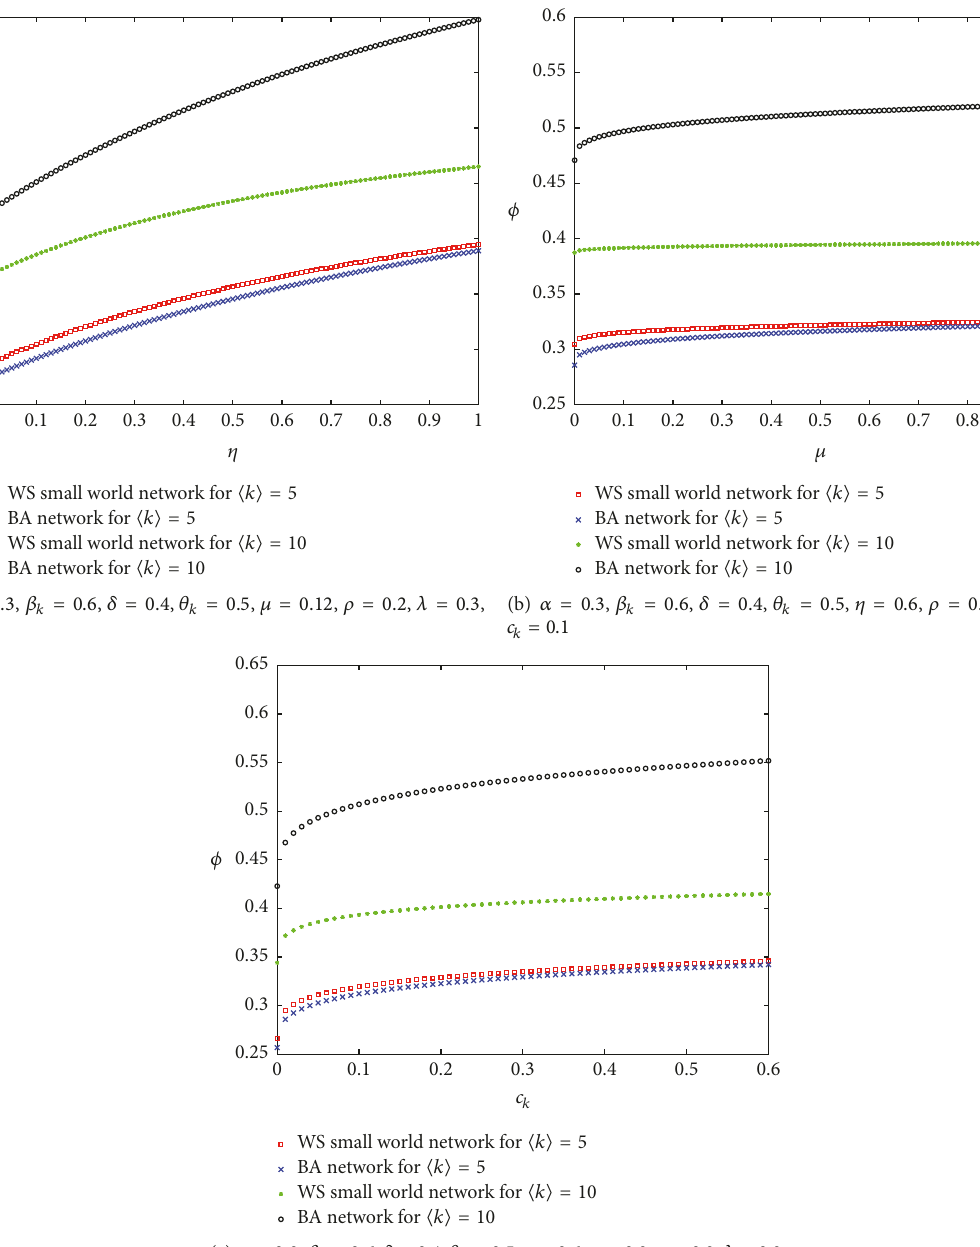
Figure 3: The evolution function of the contagious scale 𝜙 of credit risk as function in the initial fitness 𝜂 of credit risk contagion, the spillover effect 𝜇 of credit risk contagion of infected investor, and the emotional disturbance probability 𝑐 𝑘 of investor under the different network structure. (a) for 𝛼 = 0.3 , 𝛽 𝑘 = 0.6 , 𝛿 = 0.4 , 𝜃 = 0.5 , 𝜇 = 0.12 , 𝜌 = 0.2 , 𝜆 = 0.3 , 𝑐 𝑘 = 0.1 ; (b) for 𝛼 = 0.3 , 𝛽 𝑘 = 0.6 , 𝛿 = 0.4 , 𝜃 = 0.5 , 𝜂 = 0.6 , 𝜌 = 0.2 , 𝜆 = 0.3 , 𝑐 = 0.1 ; (c) for 𝛼 = 0.3 , 𝛽 = 0.6 , 𝛿 = 0.4 , 𝜃 = 0.5 , 𝜂 = 0.6 , 𝜇 = 0.12 , 𝜌 = 0.2 , 𝜆 = 0.3 𝑘 𝑘